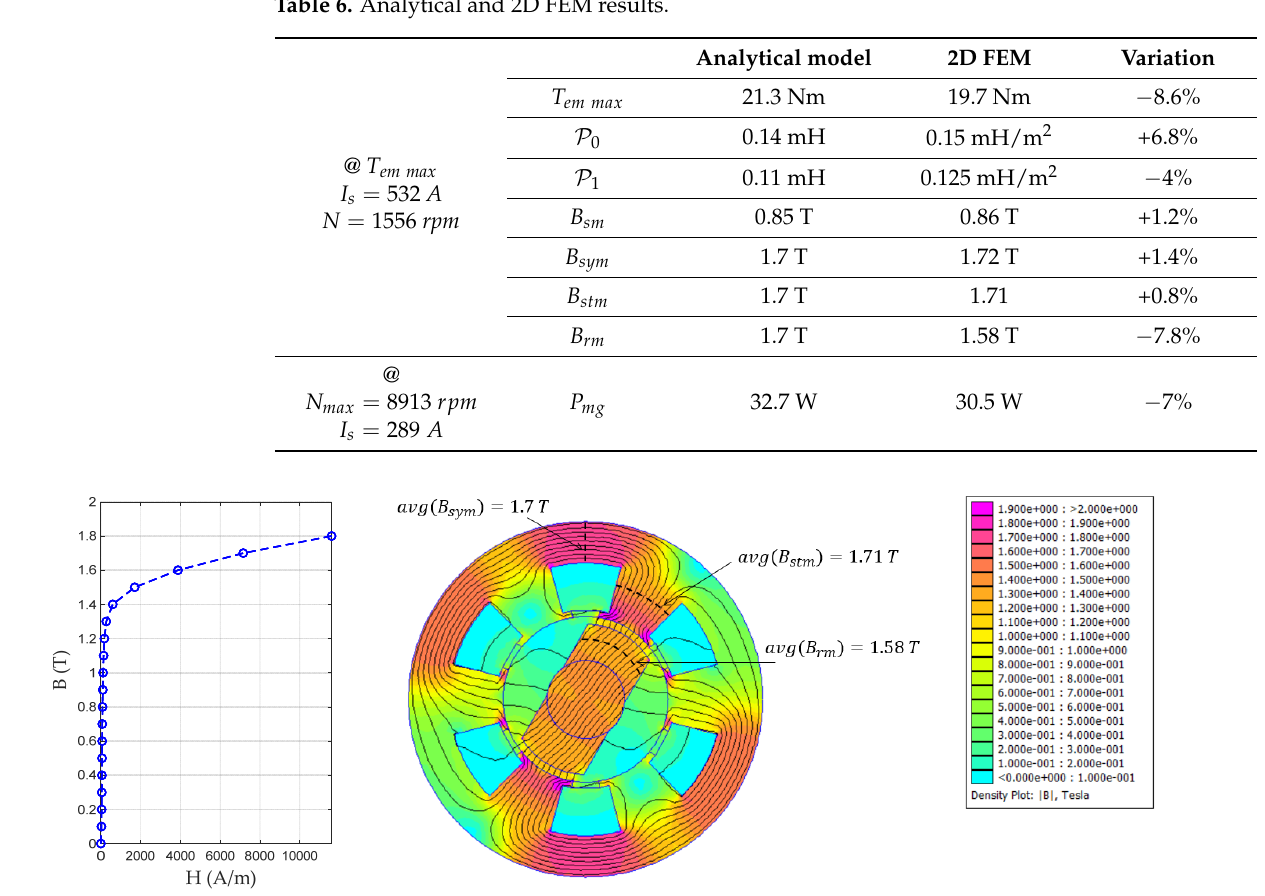
Figure 11. M270-35 A Flux lines and flux density distribution at full load. Figure 11. M270 ‐ 35 A Flux lines and flux density distribution at full load.